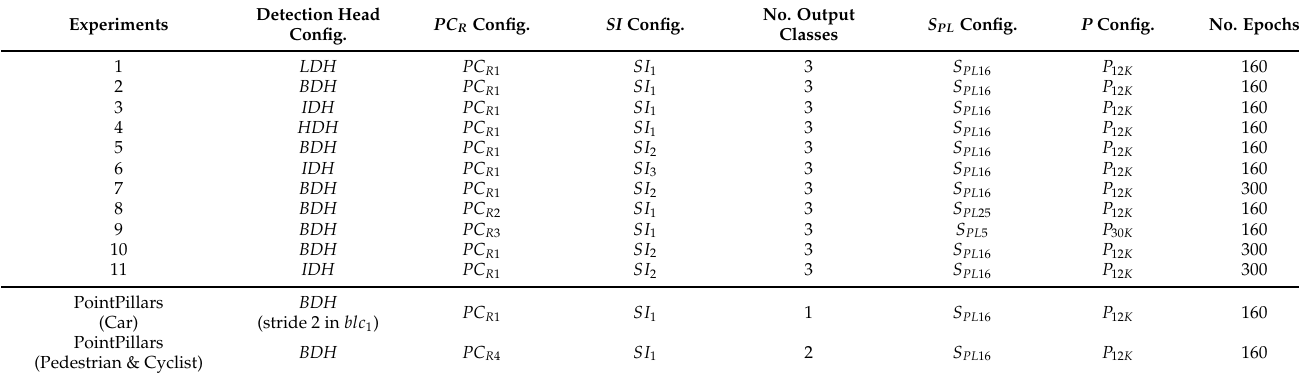
Table 6. The set of experiments conducted and respective network configurations. Detection Head Experiments